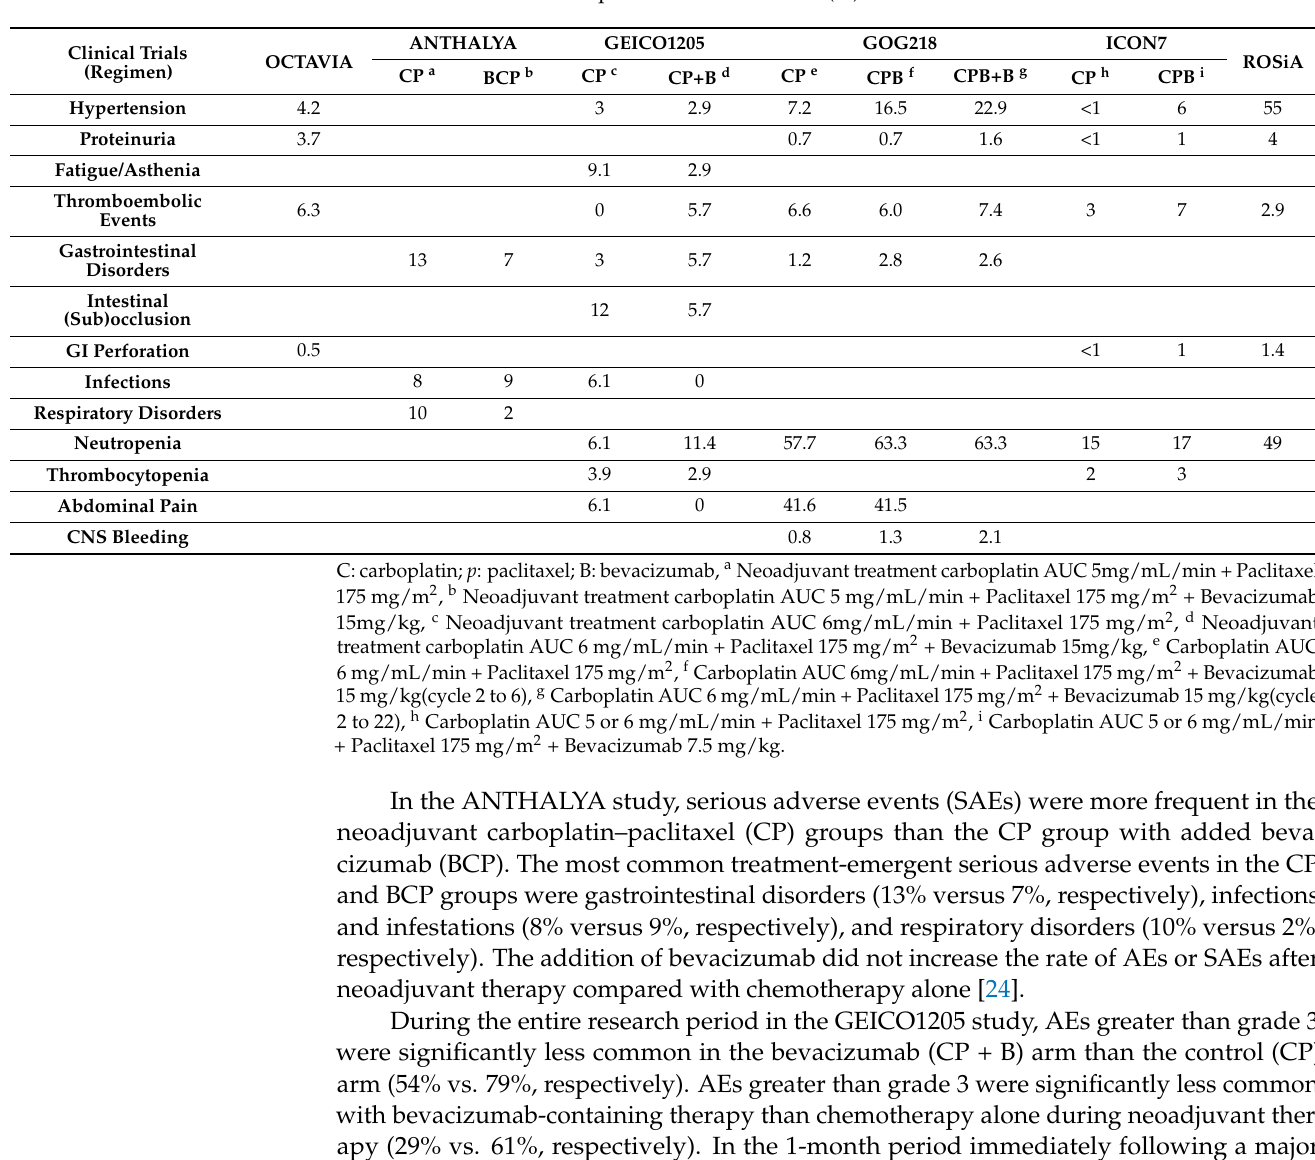
Table 2. Adverse effects reported in clinical trials